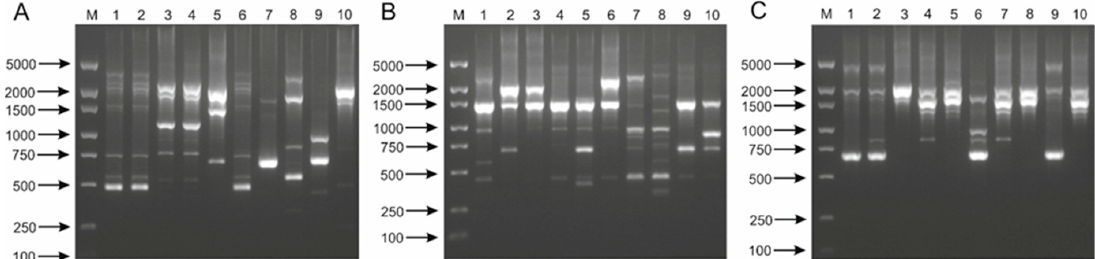
Figure 3. Randomly amplified polymorphic DNA (RAPD)-PCR patterns obtained with 80B_RAPD_M13 primer for 30 lactobacilli belong to L. casei group. Analysis of the discriminatory power of the procedure applied was performed for 10 strains of L. casei ( A )—M, DNA molecular marker; 1, LMG 6904; 2, LMG 23516; 3, LMG 24099; 4, LMG 24102; 5, JCM 2120; 6, JCM 8129; 7, JCM 8608; 8, JCM 8677; 9, JCM